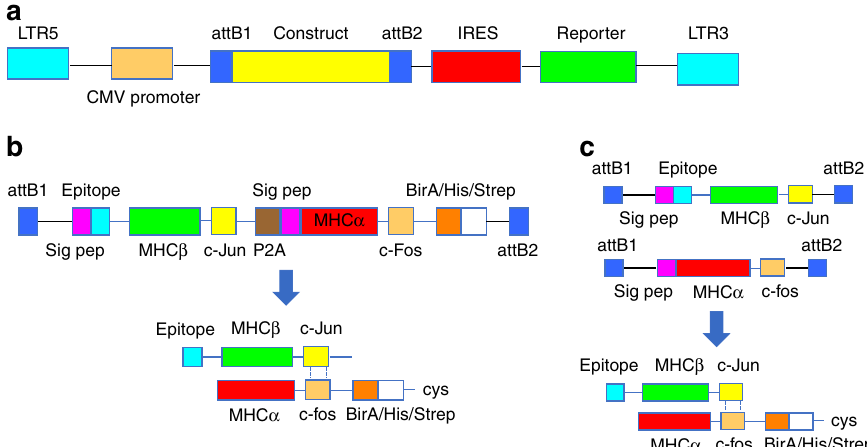
Fig. 1 pMHCII-expression construct design. Cartoons depict the general structure of the lentiviral system ( a ) and the type of constructs used ( b , c ). b Structure of a P2A-linked pMHC β and MHC α chain-coding construct (top) and a representation of the resulting pMHCII product secreted into the cell culture supernatant (bottom). c Single pMHC β - or MHC α chain constructs that were serially transduced into CHO cells to produce the resulting pMHCII αβ heterodimers